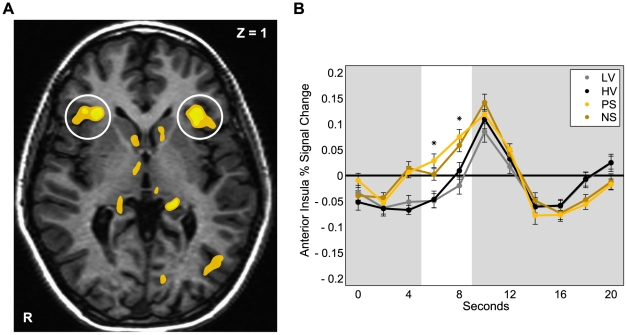
Skewness increases Anterior Insula activation.
A. Skewed versus Symmetric; p<0.001 uncorrected, p<0.05 whole-brain corrected. (Table S1). B. Time courses extracted from anterior insula for gambles (*Positive- and Negative-Skew vs. Low- and High-Variance, p<0.05). Lines represent standard errors of the mean. The white bar highlights the anticipatory period (shifted by 6 s to account for the hemodynamic lag).